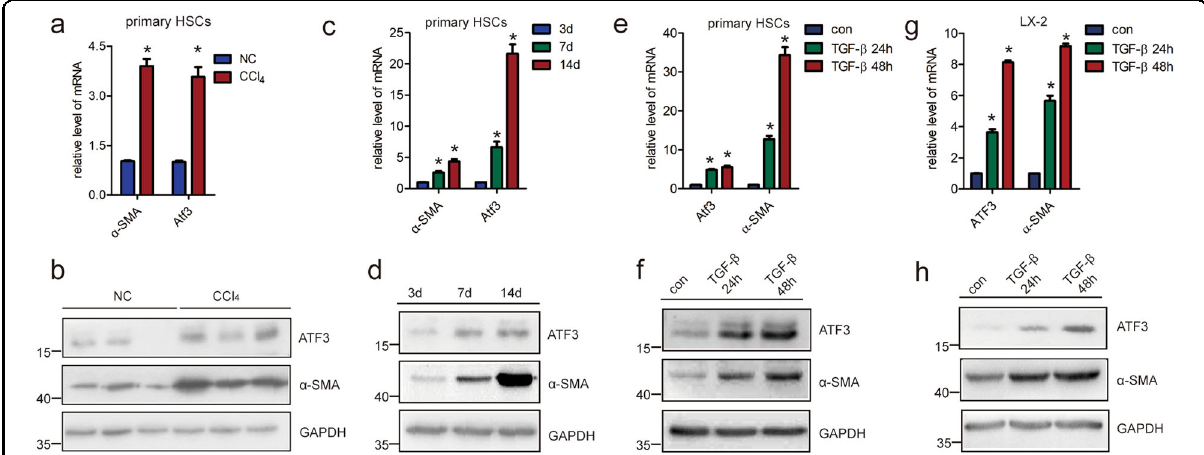
Fig. 2 ATF3 is upregulated in activated HSCs. a , b Primary HSCs were isolated from livers of Balb/c mice treated with CCl 4 or oil for 8 weeks, and the expression of ATF3 and α -SMA was determined by qRT-PCR and western blot. c , d The ATF3 and α -SMA level was measured by qRT-PCR and western blot in the HSCs after culture-induced activation. e , f Primary HSCs cultured at day 3 were stimulated with 10 ng/ml TGF- β for 24 or 48 h and the expression of ATF3, α -SMA was measured by qRT-PCR and western blot. g , h LX-2 cells were stimulated with TGF- β for 24 or 48 h and the expression of ATF3, α -SMA was measured by qRT-PCR and western blot. The data were expressed as the mean ± SEM for at least triplicate experiments, GAPDH was used as an internal control; * p <